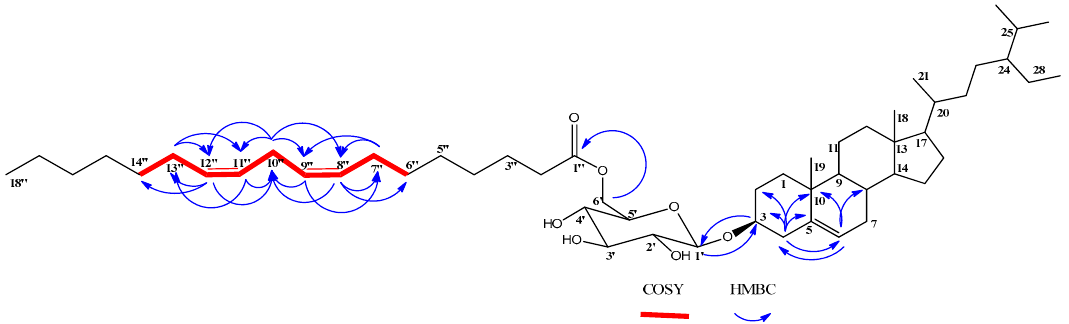
Figure 1. Structure of compound 1.